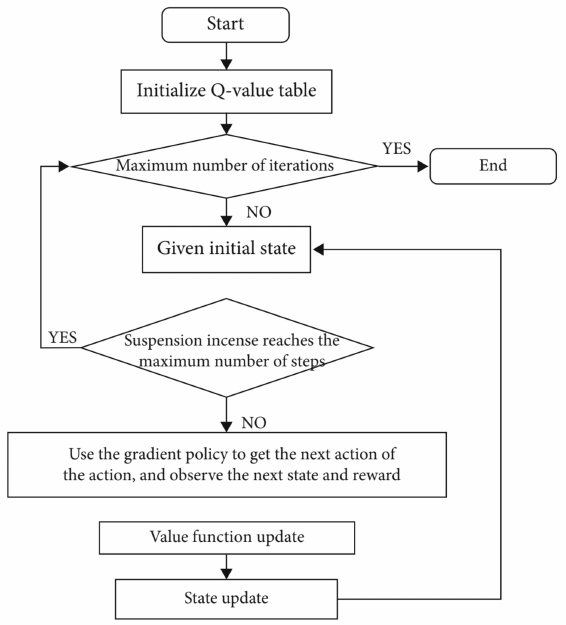
Figure 4. Flow diagram of optimization using DQN